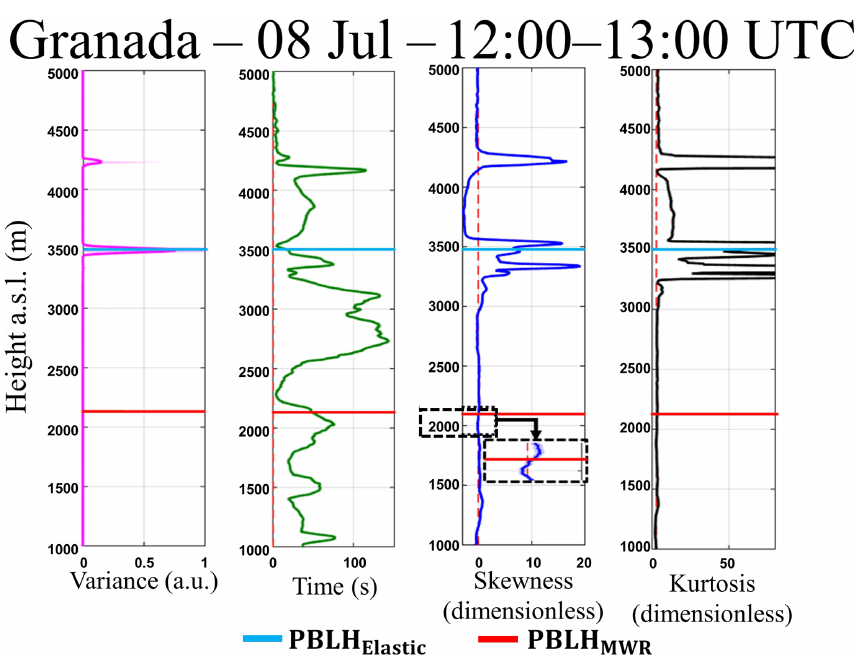
Figure 18. Statistical moments obtained from 532nm wavelength data of elastic lidar (MULHACÉN) in Granada from 12:00–13:00UTC on 8 July 2016. From left to right is the variance ( σ 2 ), integral timescale ( τ RCS (cid:48) ), skewness ( S RCS (cid:48) ) and kurtosis ( K RCS (cid:48) ). RCS (cid:48)